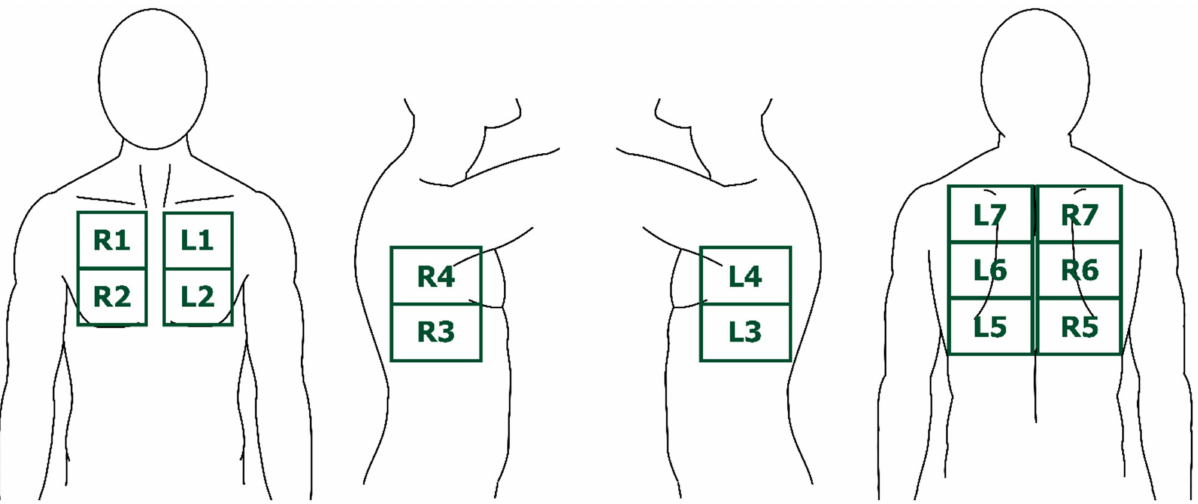
Figure 1. The seven lung ultrasound (LUS) zones on each hemithorax corresponding to the anterior, lateral, and posterior thorax wall. Abbreviations: L = left. R =